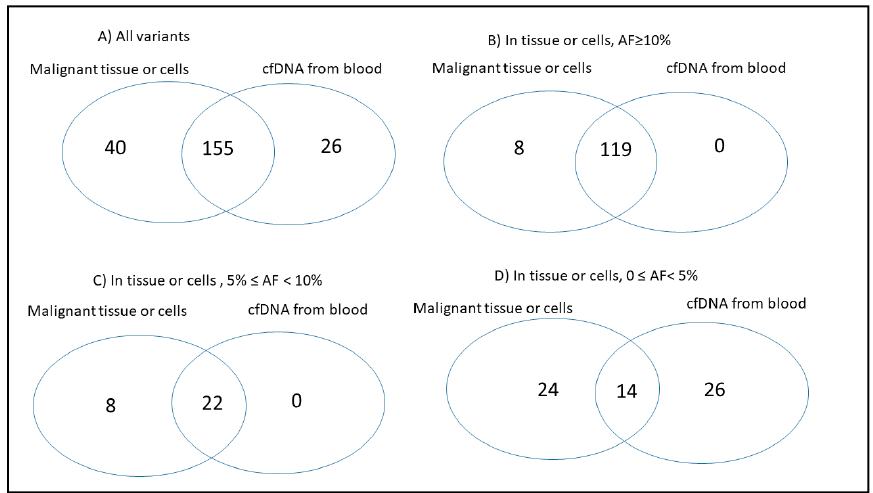
Figure 3. Variant concordance between malignant tissue/cells and paired cfDNA from blood (plasma or serum) in 15 patients in which blood and tissue samples were collected at the same time-point. ( A ) Considering all the variants; ( B ) For variants with AF ≥ 10% in malignant tissue or cells; ( C ) For variants with 5% ≤ AF < 10% in malignant tissue or cells; ( D ) For variants with AF < 5% in malignant tissue or cells.